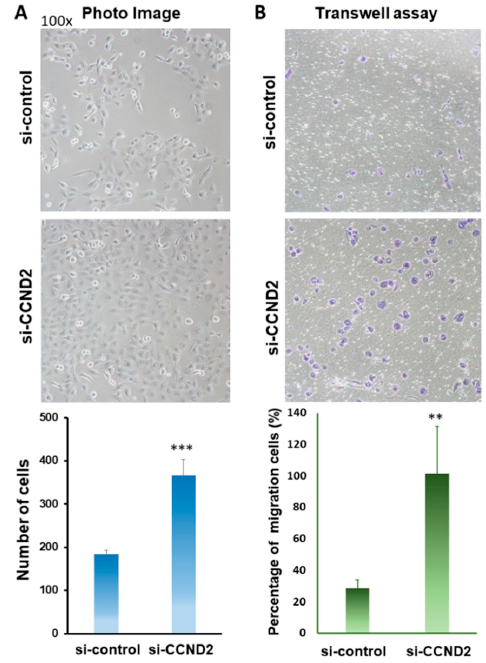
Figure 4. CCND2 controls cell growth and motility ( A ) Photograph of CCND2 knockdown-induced H1299 lung cancer cell proliferation (upper panel, original magnification 100 × ) and bar graph demonstrating the relative cell proliferation rates assayed by cell counting (lower panel). ( B ) The Transwell assay was used to further investigate the migration abilities of H1299 cancer cells. The images represent treatment with si-control and si- CCND2 (upper panel, original magnification, 100 × ). The average number of migration cells (those that passed through the membrane) was counted in five different fields (lower panel). ** p = 0.006, *** p ≤ 0.001.